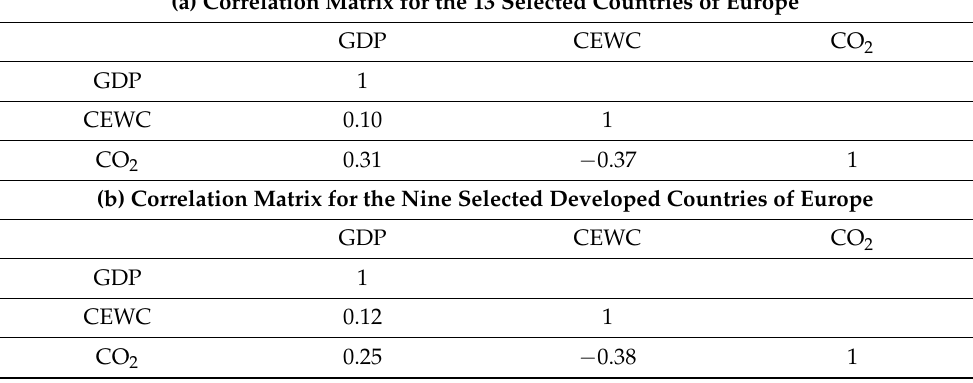
GDP CEWC CO 2 GDP 1 CEWC 0.12